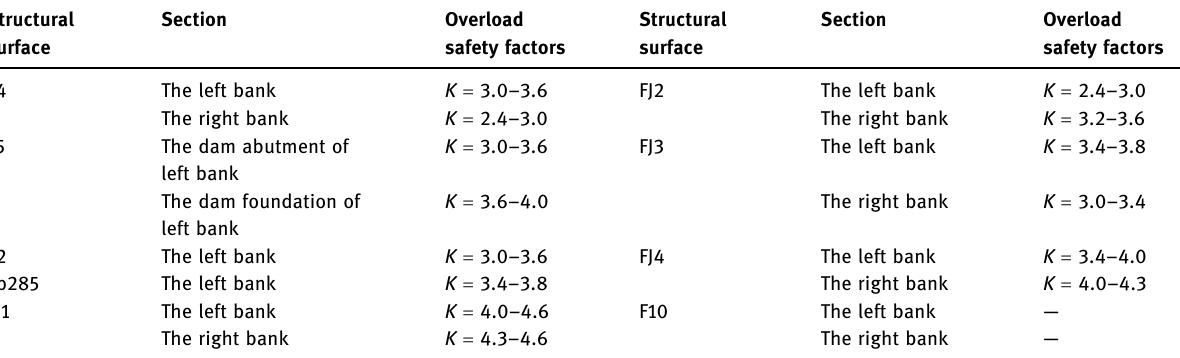
Table 3: The overload safety factors of structural surface Structural surface